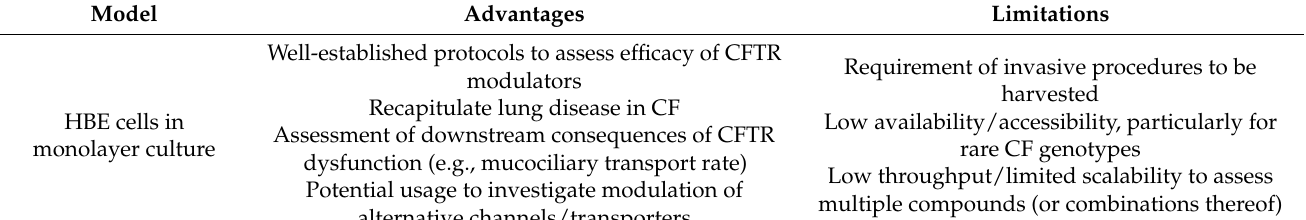
Table 2. Key advantages and limitations of patient sample-derived models to assess CF